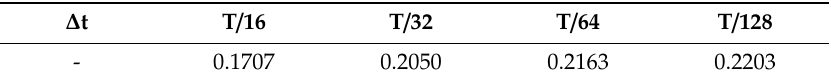
Table 2. Convergence of η for NE s = 32, NE c = 48.